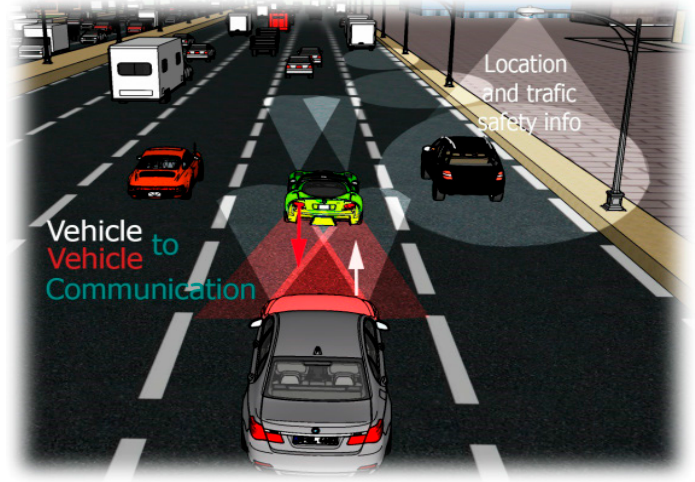
Figure 1. Visible light communications (VLC) usage scenario in vehicular applications.